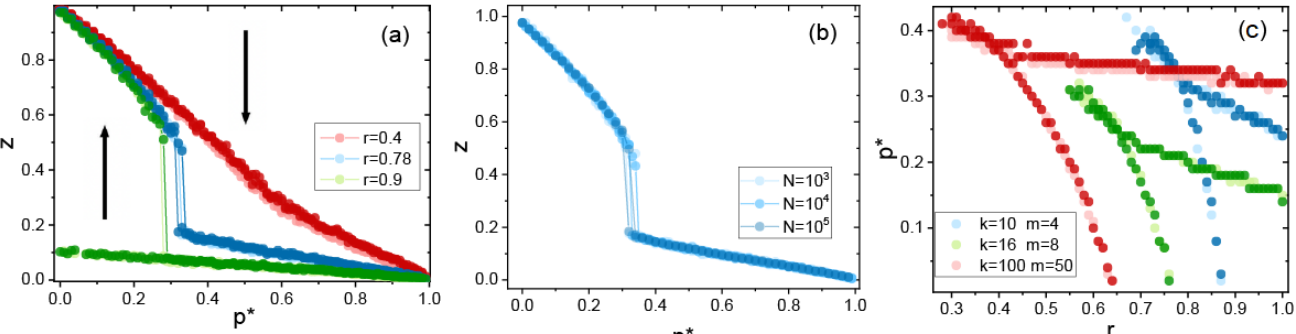
Figure 4. Phase diagrams of the ER network. ( a ) Simulation results of the average fraction of nodes for three different r , and the parameters are k = < 10 > , m = 4, and N = 10 5 . ( b ) Simulation results of the average fraction of nodes for three different r values under LA for different N with < k > = 10, m = 4, and r = 0.78. ( c ) The jump point for different parameters. Dark and light symbols denote LA and RA, respectively. Simulation results have been averaged over 1000 network